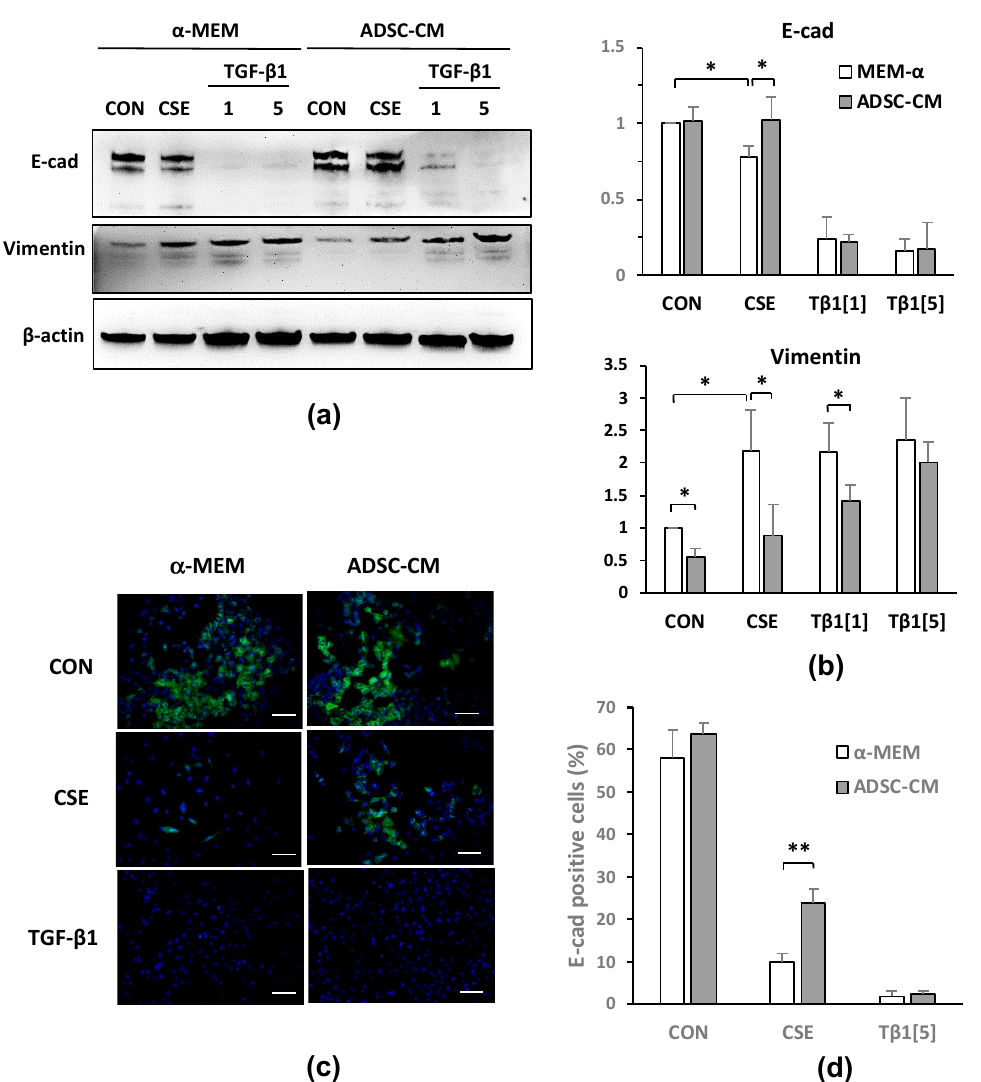
Figure 4. CSE- and TGF- β 1-induced EMT in A549 cells blocked by ADSC-CM. ( a ) E-cadherin (E-cad), vimentin, and β -actin expression by immunoblotting in A549 cells treated with 0 or 50 µ g/mL CSE and 1 or 5 ng/mL TGF- β 1 (T β 1[1], T β 1[5]) for 72 h. Both E-cad and vimentin appeared as multiple bands in Western blot. Increased vimentin and decreased E-cad expression are markers of EMT. ( b ) Summary of densitometry analysis of E-cad and vimentin expression levels normalized to the level of β -actin. The results shown were summarized from five independent experiments showing values normalized to α -MEM control sample. * p < 0.05. ( c ) Immunofluorescent staining of E-cadherin in A549 cells cultured in α -MEM or ADSC-CM and treated with CSE or 5 ng/mL TGF- β 1. Scale bar = 100 µ m. ( d ) Percentage of cells in ( c ) that showed positive staining for E-cadherin. Images from three independent experiments were analyzed by ImageJ. ** p < 0.01 compared to a-MEM+CSE group. ADSC, adipose-derived stem cell; CM, conditioned medium; CON, control; CSE, cigarette smoke